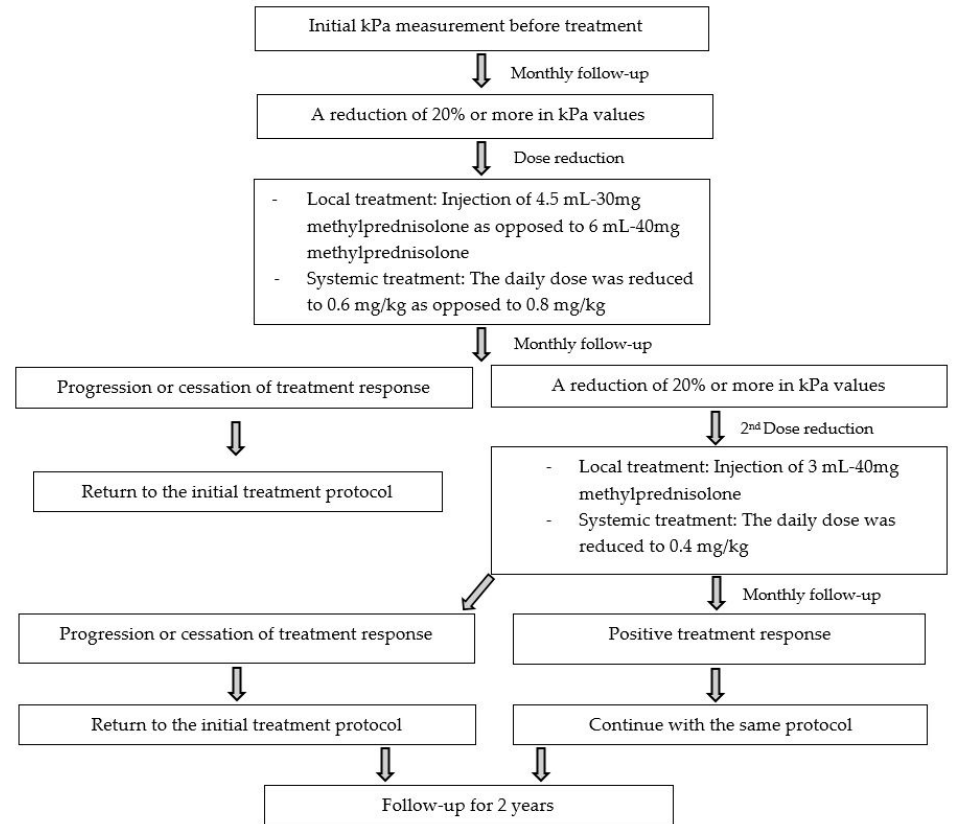
Figure 3. Assessment of treatment response and study protocol.